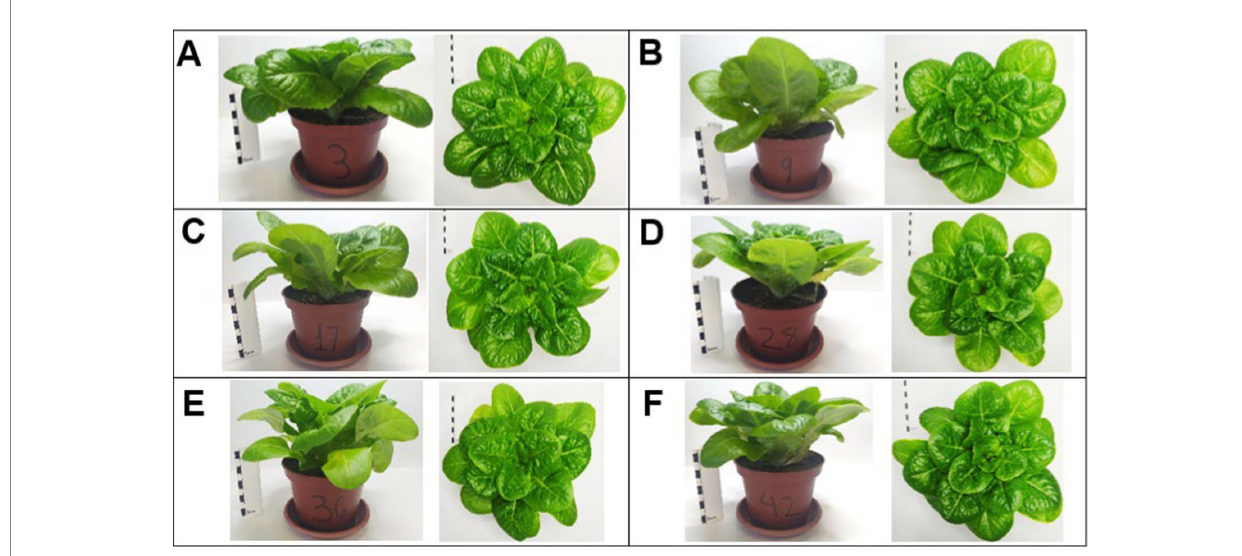
FIGURE 1 Lettuce images, axial, and zenithal planes, of every treatment (Table 1) after 40 days of cultivation. (A) control; (B) control-Fe; (C) ASCG-Fe; (D) AH160- Fe; (E) AH180-Fe; (F) AH200-Fe.